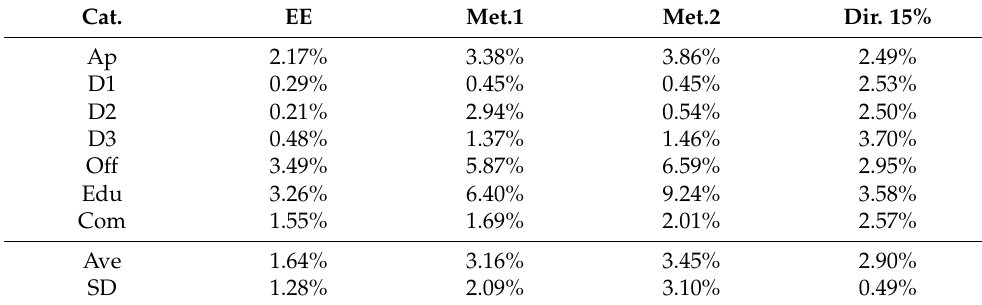
Table 9. Estimated annual renovation rates R renov , from classes F and G to class E, for all methods and building categories. Arithmetic average and standard deviation in the bottom